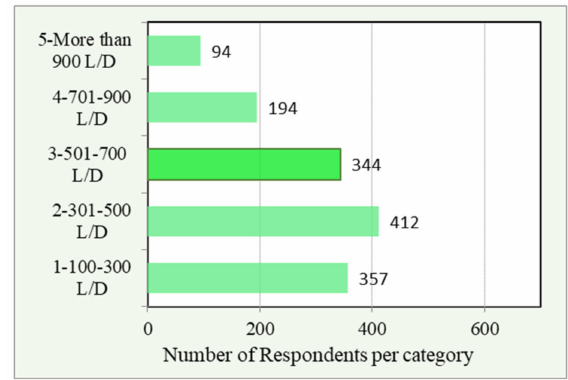
Figure 1. Public knowledge on Per capita Water Consumption (in